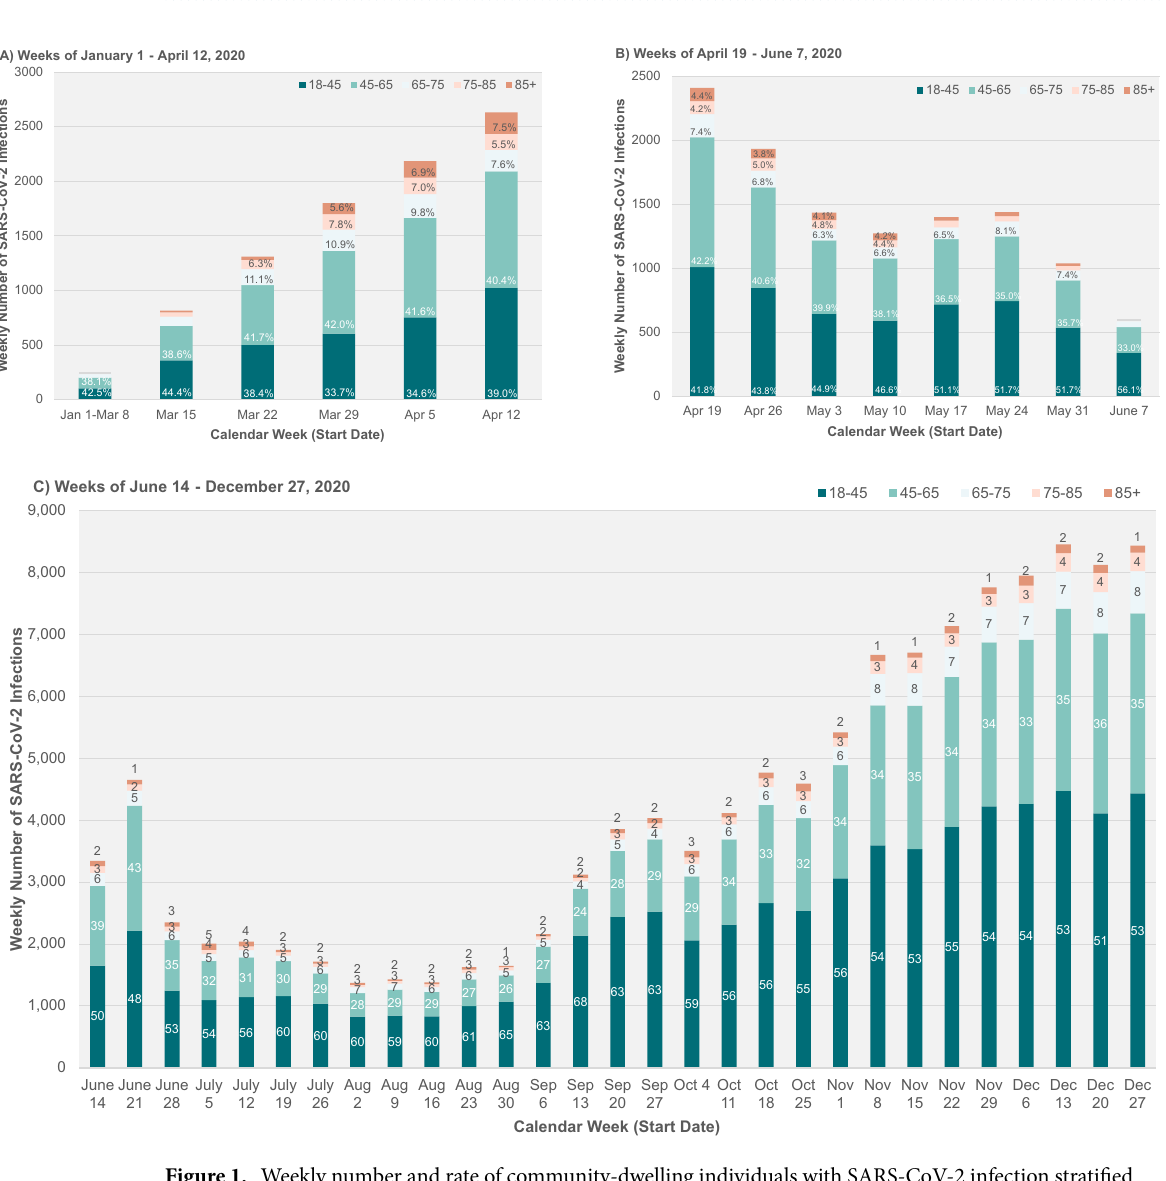
Figure 1. Weekly number and rate of community-dwelling individuals with SARS-CoV-2 infection stratified by age group during 2020, prior to ( A Weeks of January 1–April 12) and following ( B Weeks of April 19–June 7 and C Weeks of June 14–December 27) the peak of the first wave of the pandemic in Ontario, Canada. Time represented by the start of the calendar week with the weeks of January 1 through March 8 consolidated given low initial infection counts. Age groups: 18–45 years (dark green); 45–65 years (light green); 65–75 years (light blue); 75–85 years (pink); 85 years and older (orange). The proportion of weekly counts attributable to an age group is represented in each column with the percentage indicated on each section. The peak of the first wave of the pandemic regarding community-dwelling infections, using the proxy of test positivity in Ontario, correlated with the week of April 12, 2020. Ages 75 and up are combined to suppress small cells for weeks Jan 1 – Mar 8 and June 7, per ICES’ reidentification risk assessment